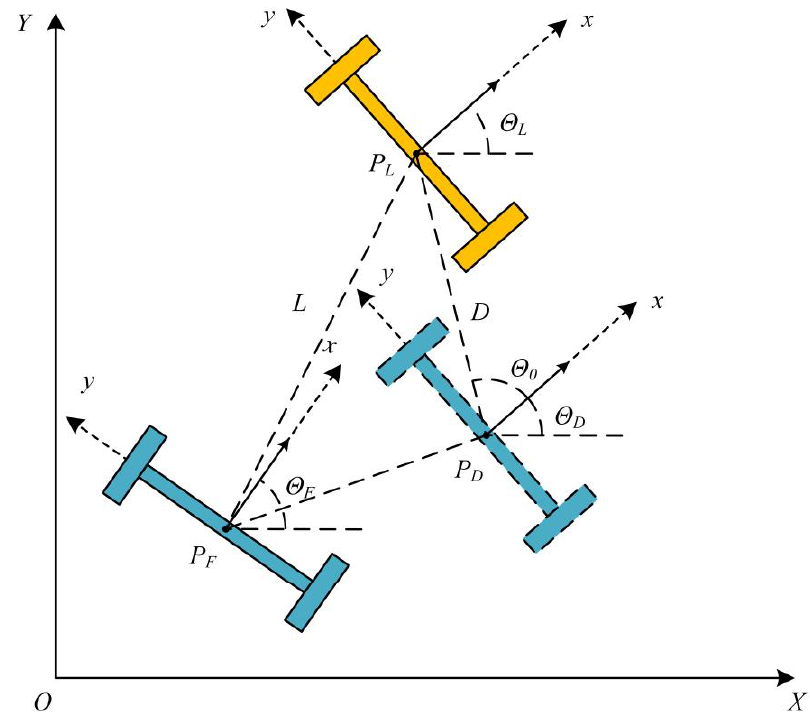
Figure 9. Schematic diagram of leader-follower method.